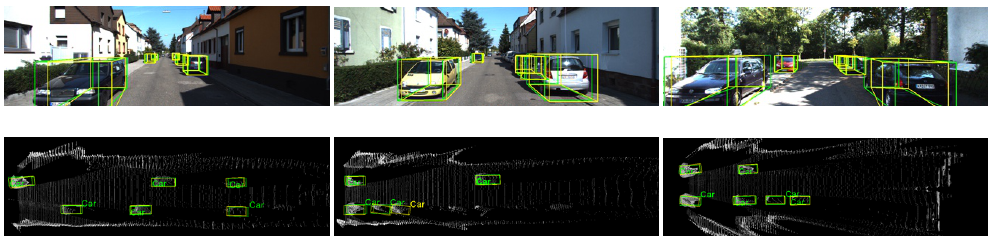
Figure 8. Detection of cars at different distances with occlusion. Top row images are frontal-view images, and bottom row images are bird’s-eye-view point cloud maps. Ground truth boxes are in green and prediction results are in yellow. Our proposed framework is able to create accurate 3D boxes at different distances and for occluded targets.